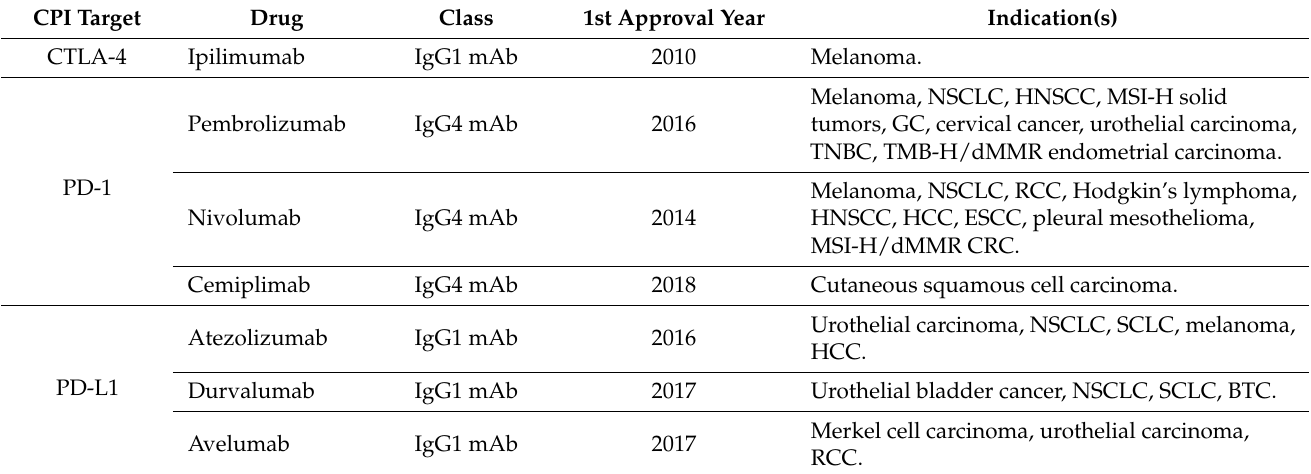
Table 1. FDA-approved immune CPIs and their